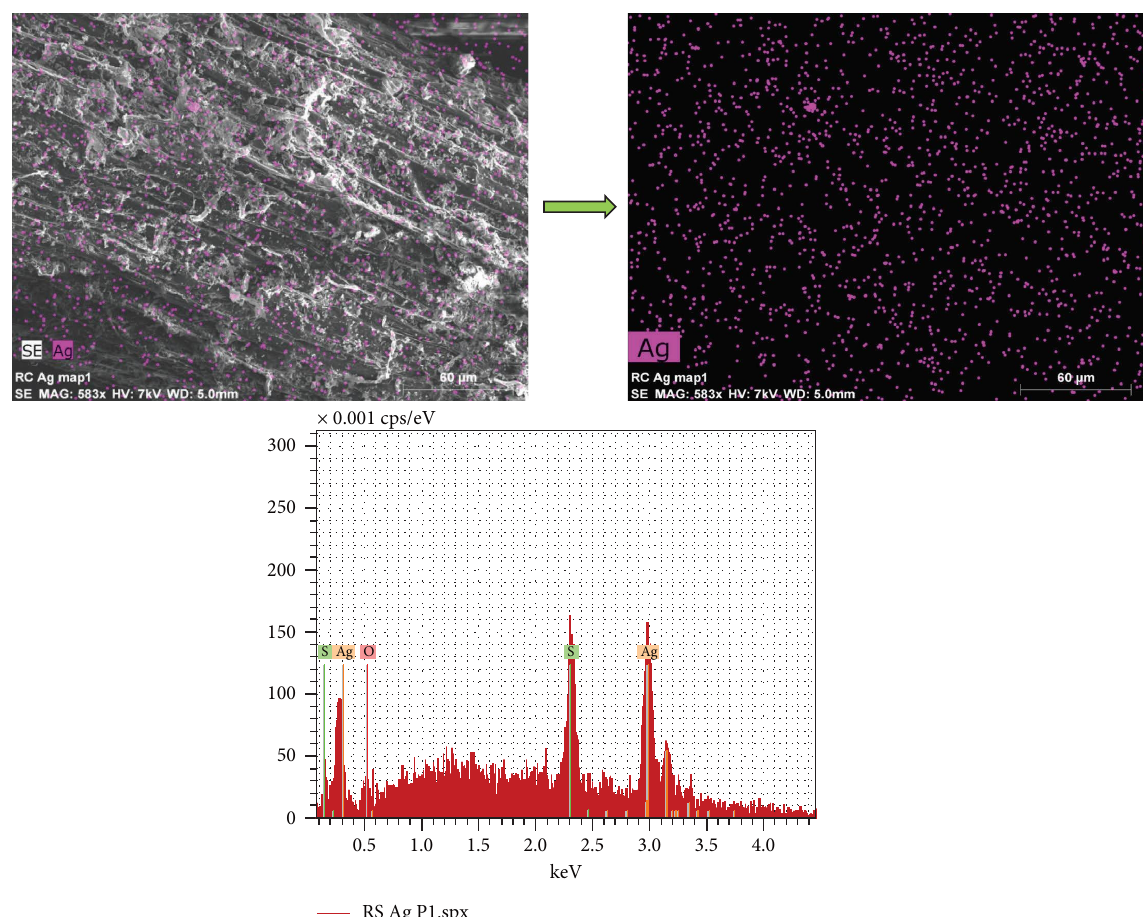
Figure 2: SEM/EDX image of cattail root showing distribution of